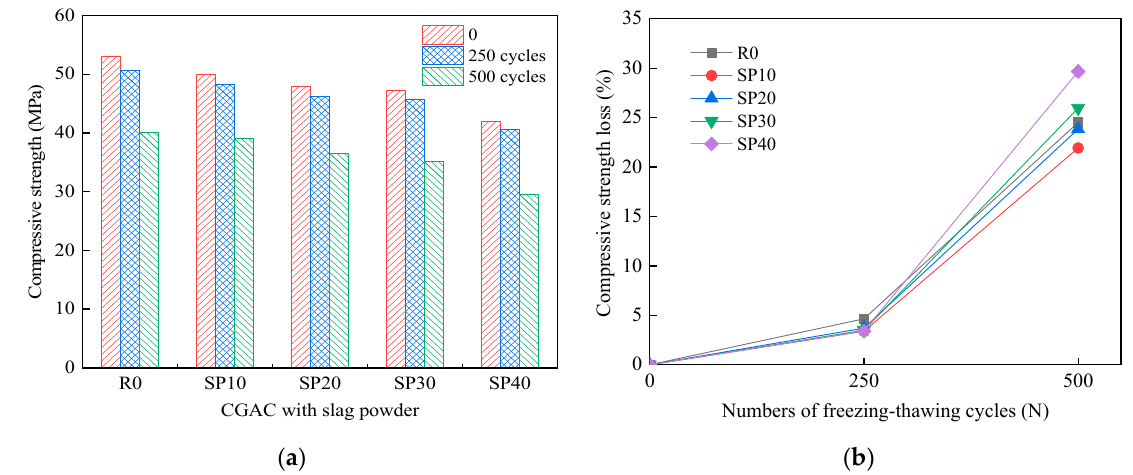
Figure 10. ( a ) Compressive strength and ( b ) compressive strength loss of CGAC with different slag powder content after F-T cycles.